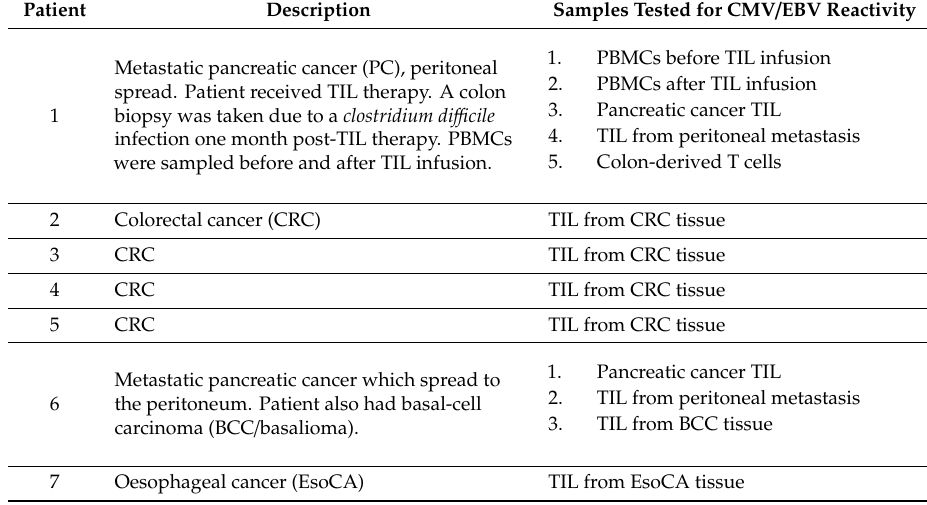
Figure 1. The anti-CMV / EBV cellular immune responses of T cells derived from patients with cancer: T-cell preparations sourced from whole PBMCs or tumour-infiltrating lymphocytes (TIL) of patients with various diagnoses of gastrointestinal malignancies were tested in a 7-day in vitro stimulation assay with CMV pp65 or EBV-EBNA1. Cell culture supernatants were harvested for IFN- γ measurement by sandwich ELISA. As positive controls, the antihuman CD3 antibody (clone OKT3) as well as the mitogen phytohaemagglutinin (PHA) were used separately to ascertain maximal T-cell responses. The antigen-driven cellular immune response is expressed as IFN- γ production per 1 × 10 5 cells over 7 days. Legend: Pat.1–7 = patients 1–7; TIL = tumour-infiltrating lymphocytes; PBMCs = peripheral blood mononuclear cells; PC = pancreatic cancer; CRC = colorectal cancer; perit.met = peritoneal metastasis; BCC = basal cell cancer (basalioma); EsoCA = oesophageal cancer. Table 1. Descriptions of the clinical samples used in the cytomegalovirus (CMV)-Epstein–Barr virus (EBV)-immunoreactivity